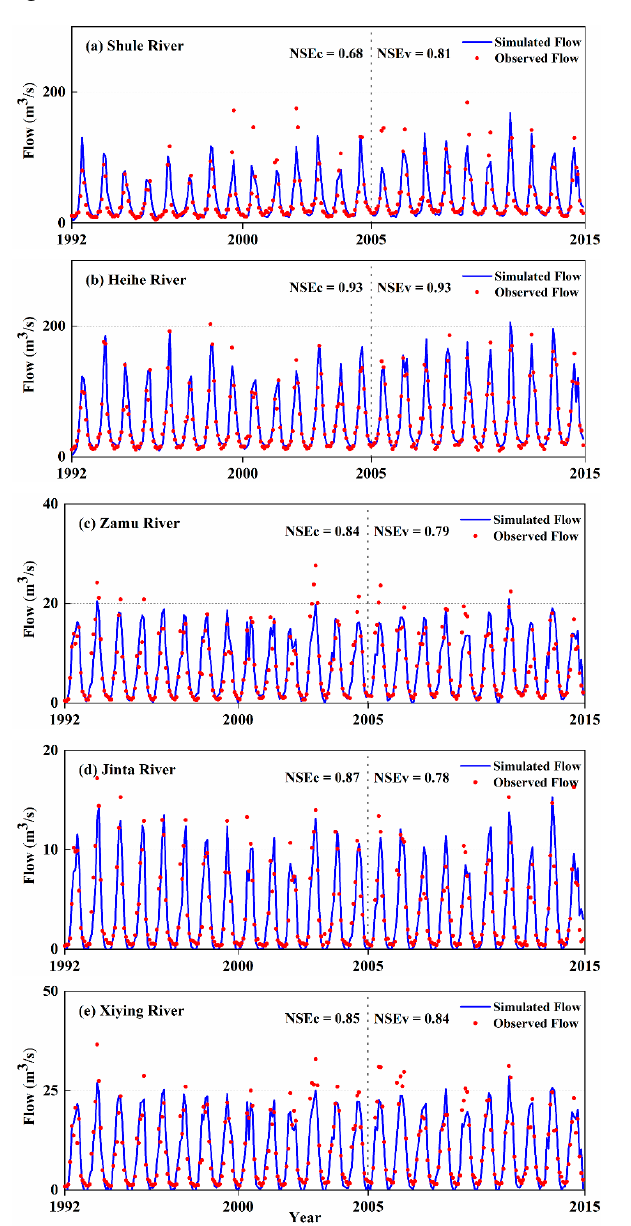
Figure A3. Runoff simulation plots obtained from the TVGM-DDF model in a typical mountainous watershed of the Hexi inland river.